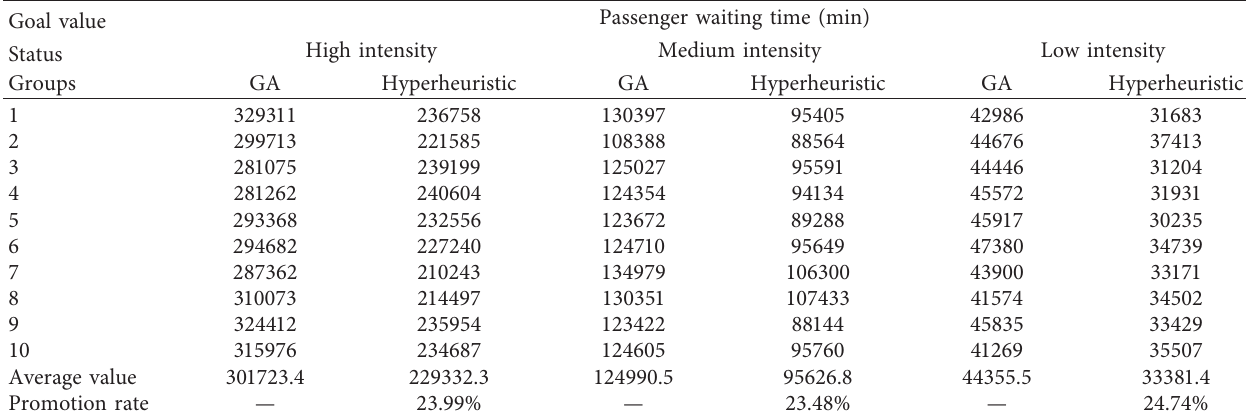
Figure 6: Passenger arrival rate under different scenarios. (a) Smooth passenger flow. (b) Increasing passenger flow. (c) Decreasing passenger flow. (d) Multisection convex passenger flow. Table 1: Results of GA and hyperheuristic algorithm under smooth passenger